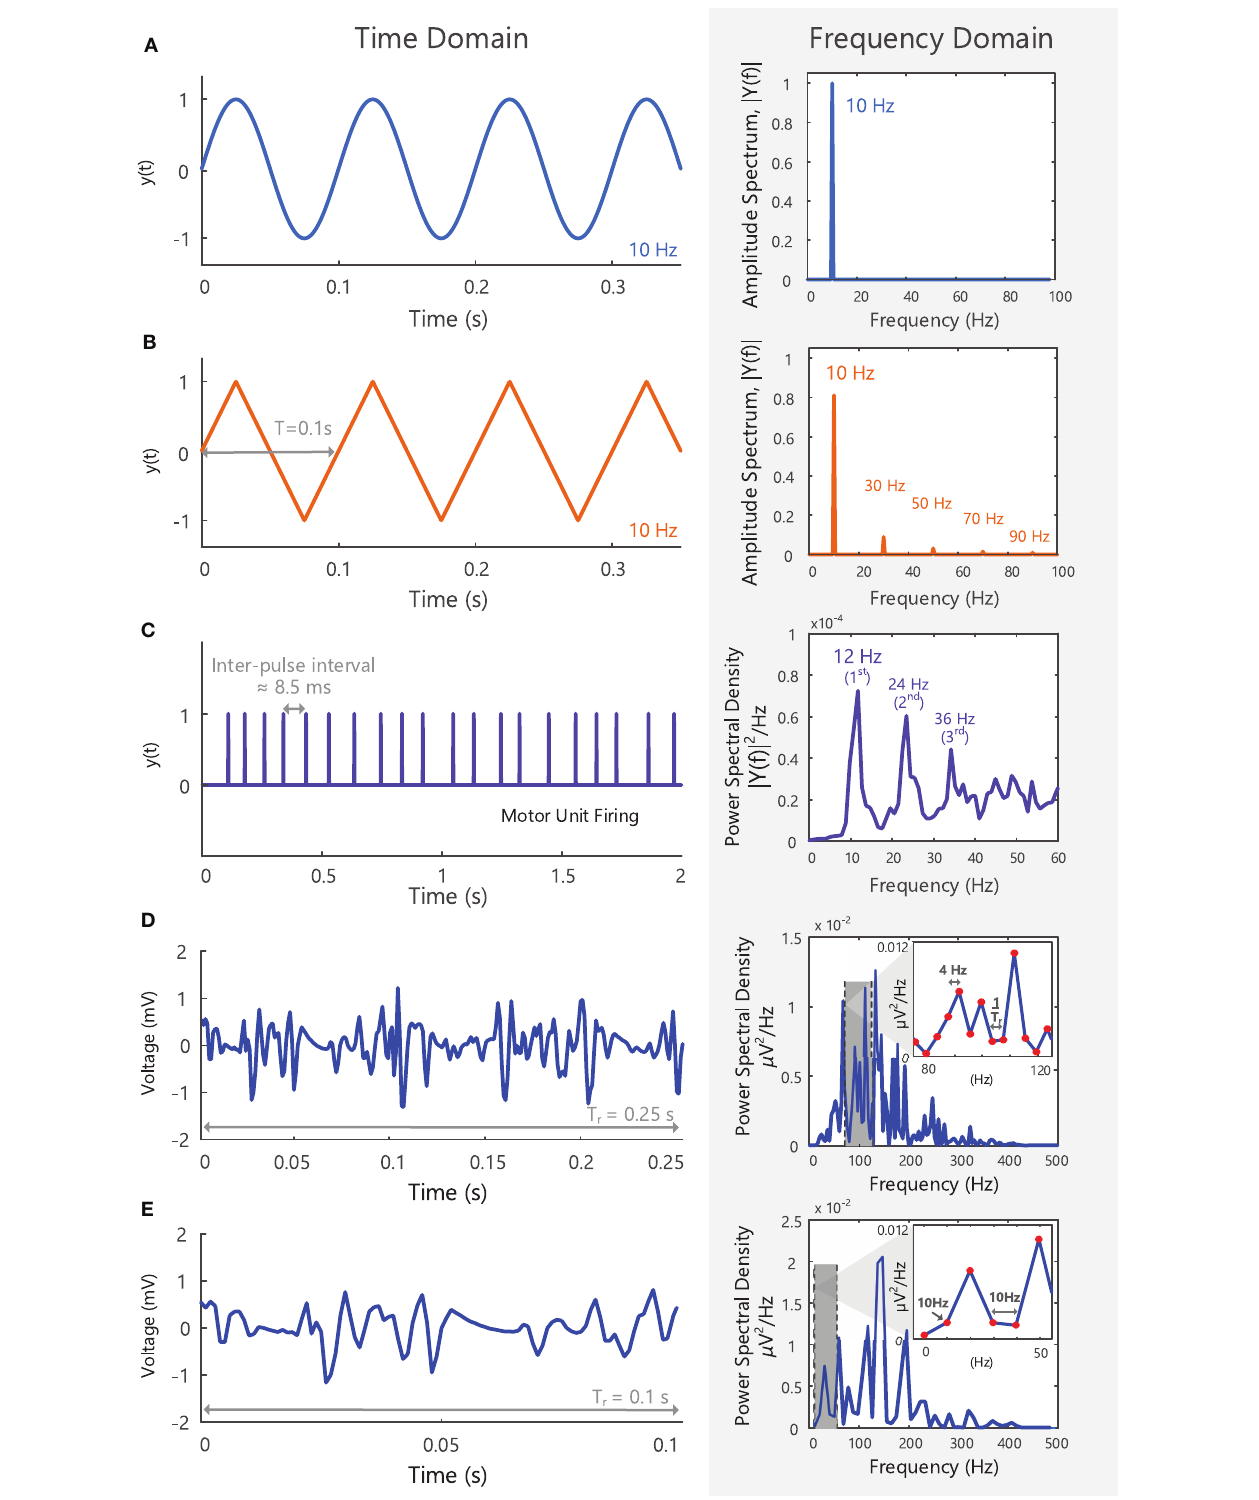
FIGURE 5 | (A) A 10Hz sine wave with an amplitude of 1, shown in the time domain, y(t), and in the frequency domain, Y(f), after applying a Fourier Transform. All the power within the signal is contained at a single frequency (i.e., fundamental frequency or first harmonic − 10Hz). (B) A triangle wave with a repetition